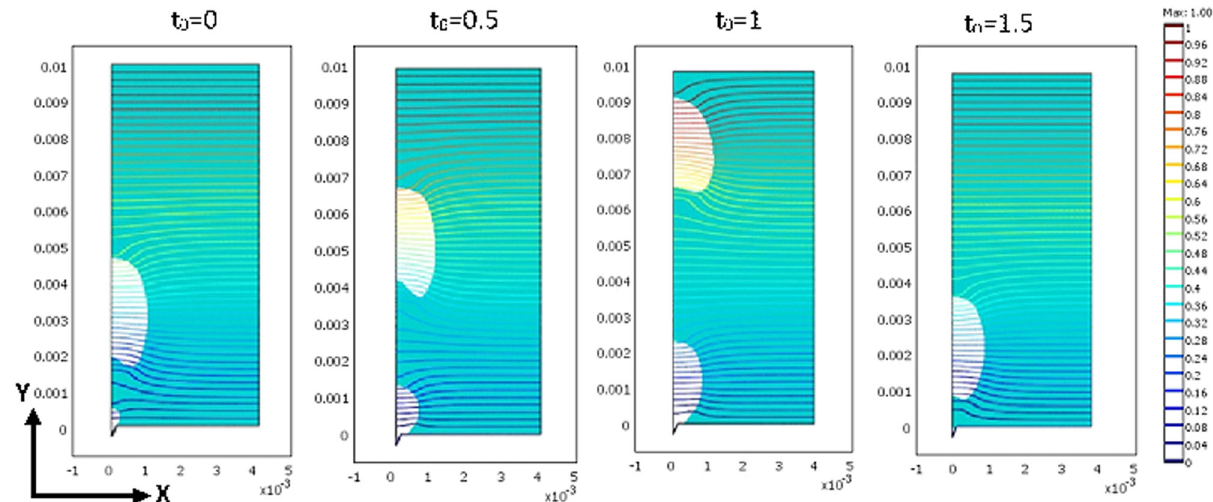
Fig. 7 Distribution of dimensionless electric potential for the superheat with temperature of 8.5 °C and contact angle of 50°. The unit of x-axis and y-axis is